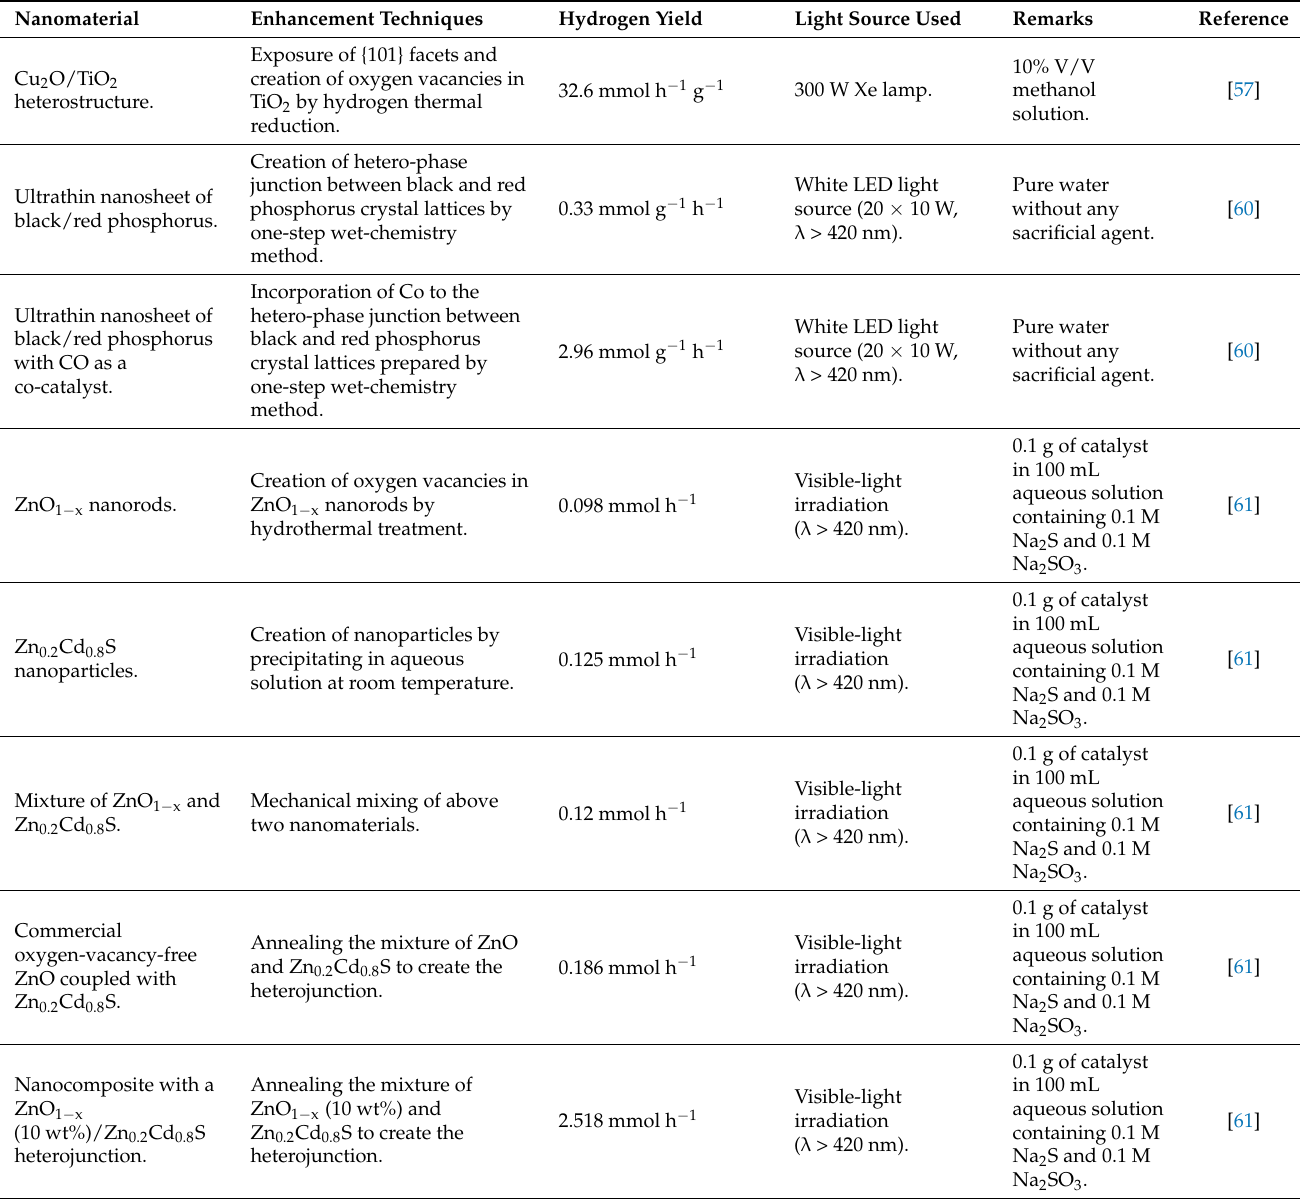
Table 2. Summary of catalytic systems related to Z-schemed